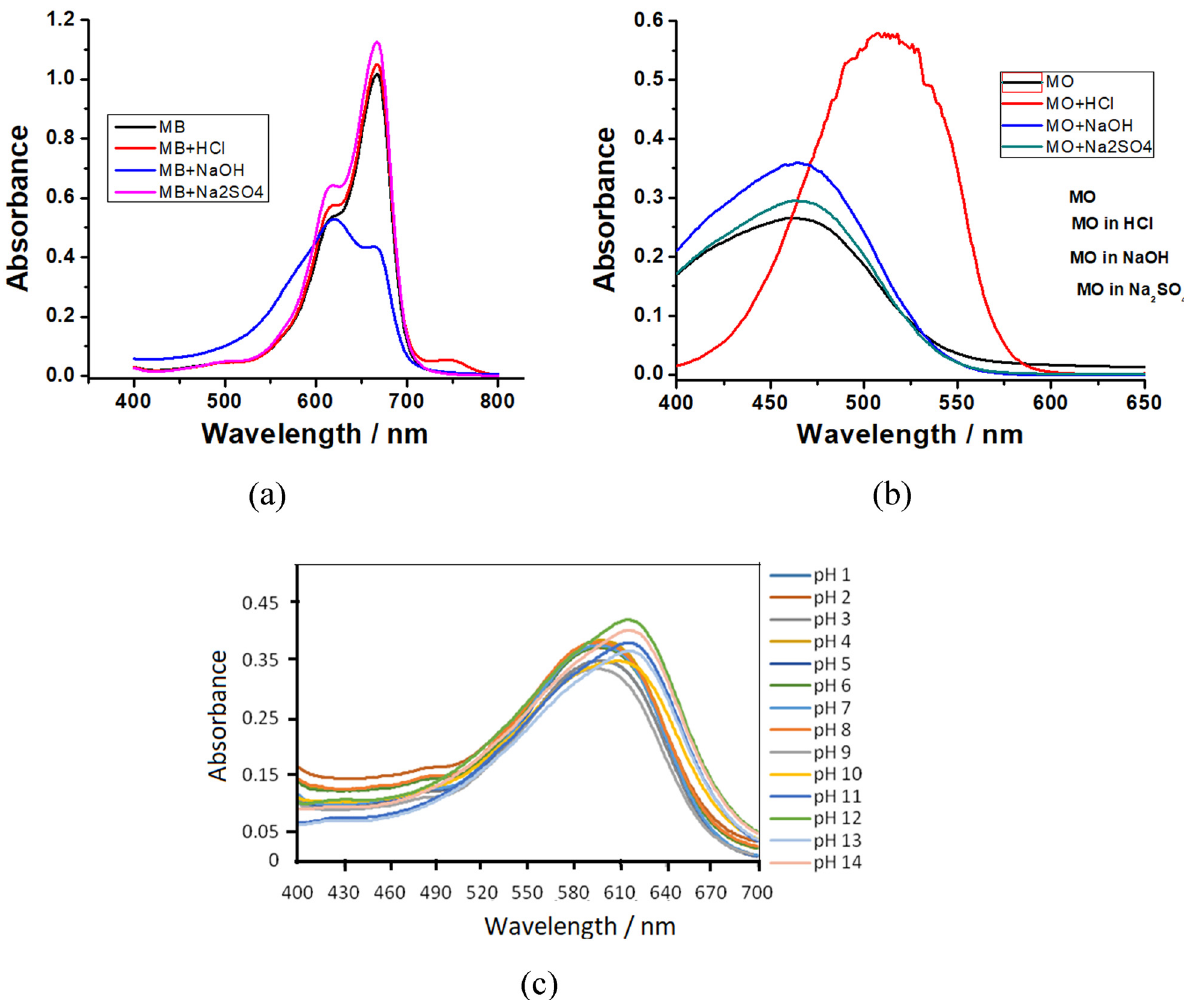
Figure 8: The maximum wavelength of ( a ) MB, ( b ) MO, and ( c ) RBB at various